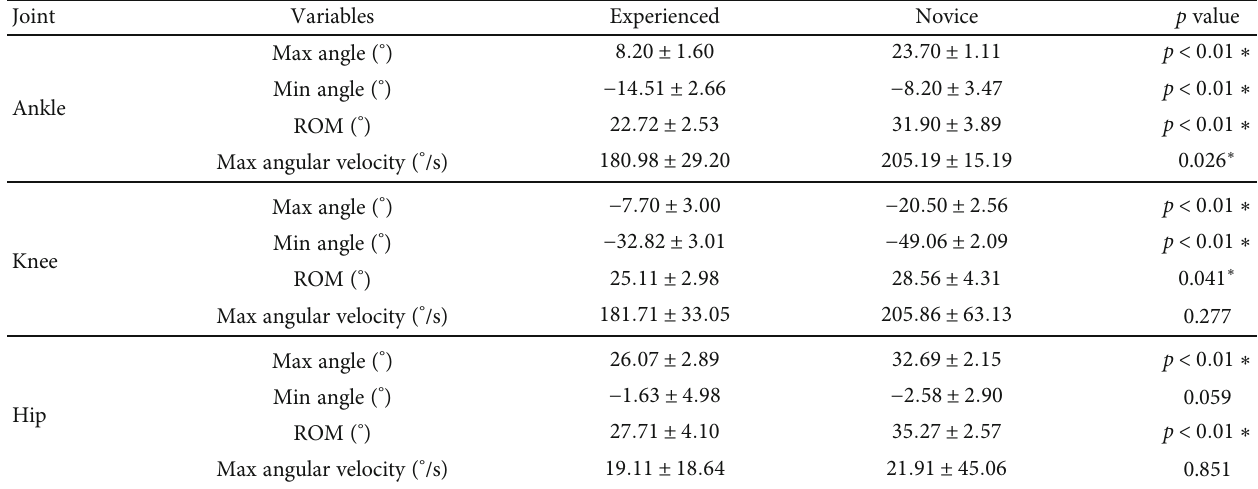
Figure 3: Pictorial illustration of the running gait cycle during the stance phase at 3.3m/s. Table 3: Ankle, knee, and hip joint kinematics during the stance phase ( n = 24